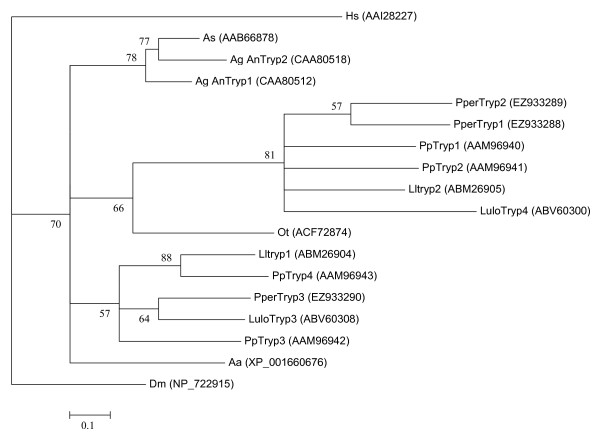
Phylogenetic analysis of putative trypsins from Anopheles stephensi (As), Ochlerotatus taeniorhynchus (Ot), Homo sapiens (Hs), Aedes aegypti (Aa), Anopheles gambiae (Ag), Phlebotomus perniciosus (Pper), Lutzomyia longipalpis (Lulo), Phlebotomus papatasi (Pp) and Drosophila melanogaster (Dm). GenBank accession numbers are given in parentheses and node support is indicated by the bootstrap values.